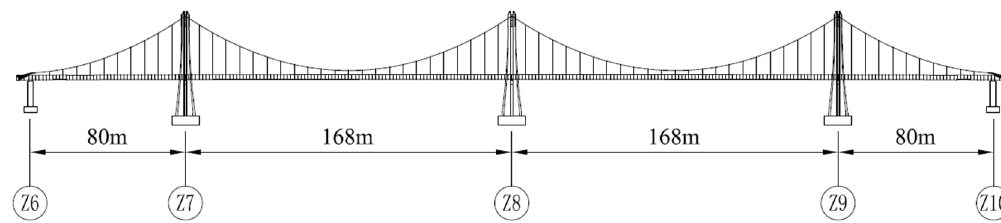
Figure 5. Layout of the Luozhou Bridge.